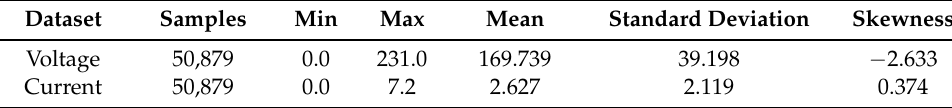
Table 2. Basic statistical properties of the dataset considered in the case